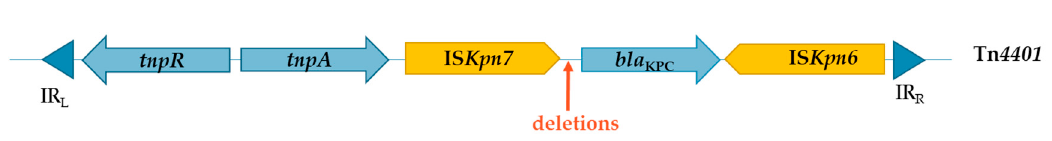
Figure 1. Diagram of Tn 4401 structure, according to Nordmann et al., 2011 [32] and Partridge et al., 2018 [36]. Genes and their corresponding transcription orientation are indicated by large blue arrows. The Tn 4401 is delimited by two inverted repeat (IR) sequences, represented by dark blue triangles. Tn 4401 carries bla KPC gene, it is a Tn3-type transposon which possess a resolvase and a transposase respectively encoded by tnpR and tnpA and two insertion sequences (yellow large arrows) IS Kpn6 and IS Kpn7 . Approximative position of deletions leading to different variants of Tn 4401 are represented by the thin orange arrow.